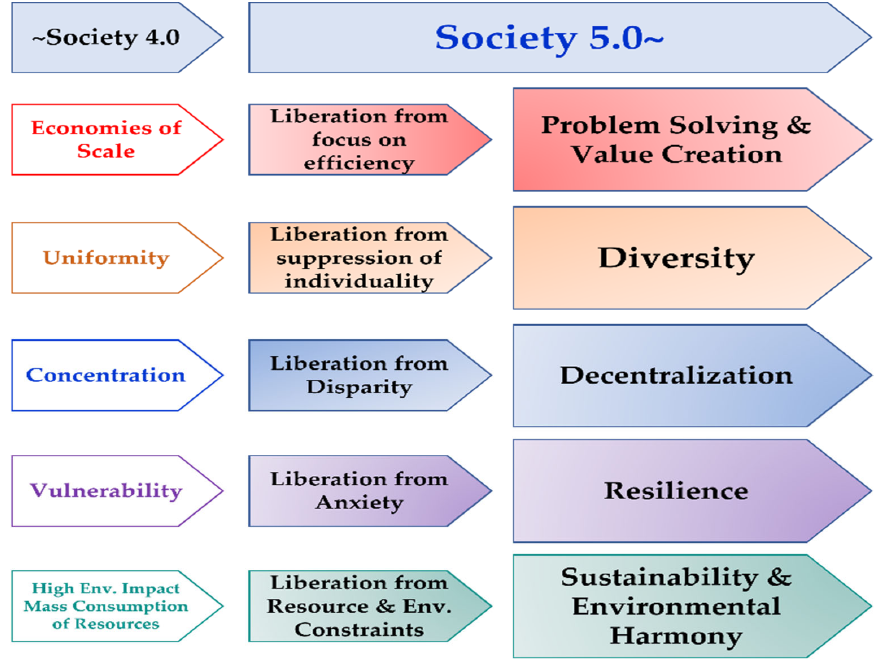
Figure 8. Changes from Society 4.0 to 5.0. Table 2. The 17 sustainable development goals (SDGs) to transform our world, derived from [37]. The 17 Sustainable Development Goals